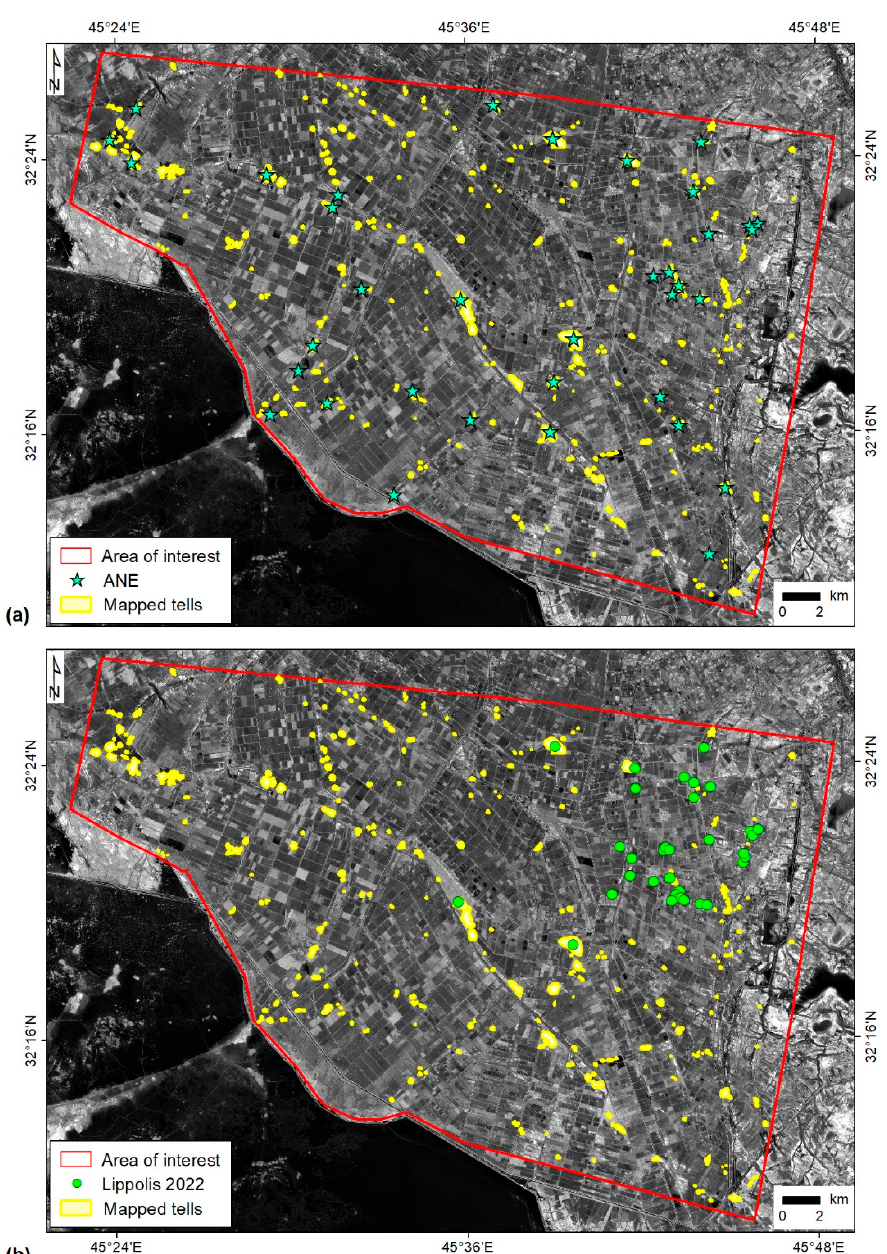
Figure 5. Spatial distribution of the mapped tells within the test area, onto high resolution satellite imagery (contains Copernicus Sentinel-2 data, 2019), compared to ( a ) Ancient Near East (ANE) sites as mapped by [23] and ( b ) tells investigated and reported by [49].